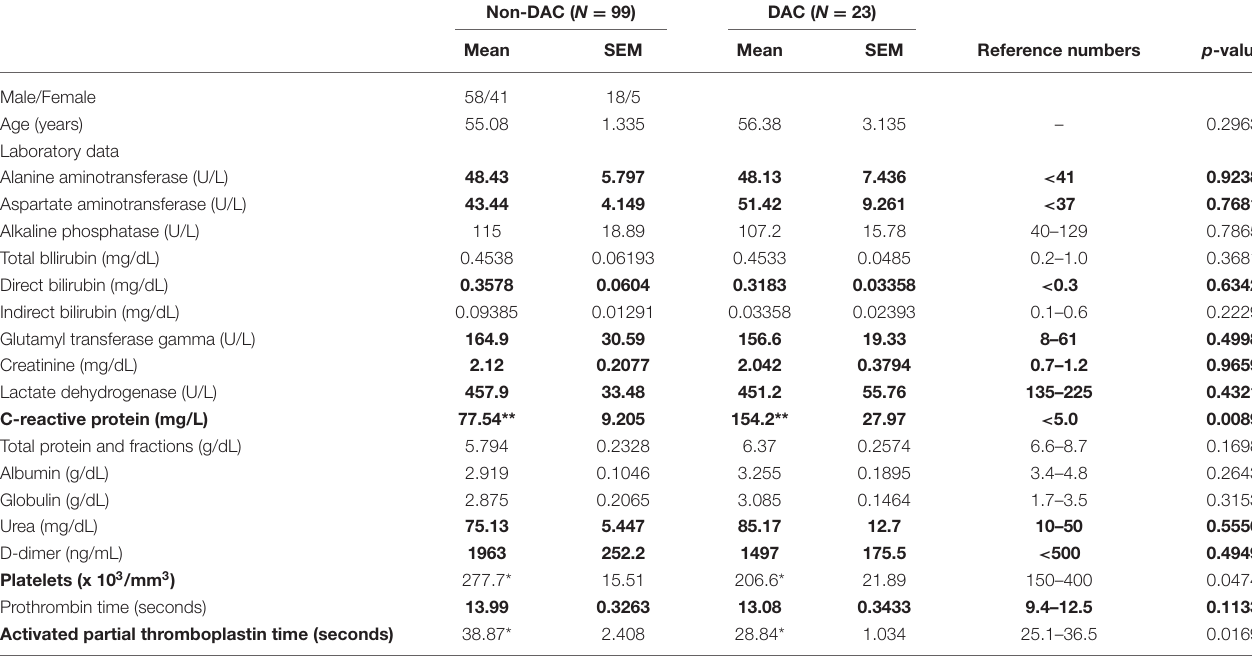
TABLE 1 | Patients’ clinical characteristics and laboratory